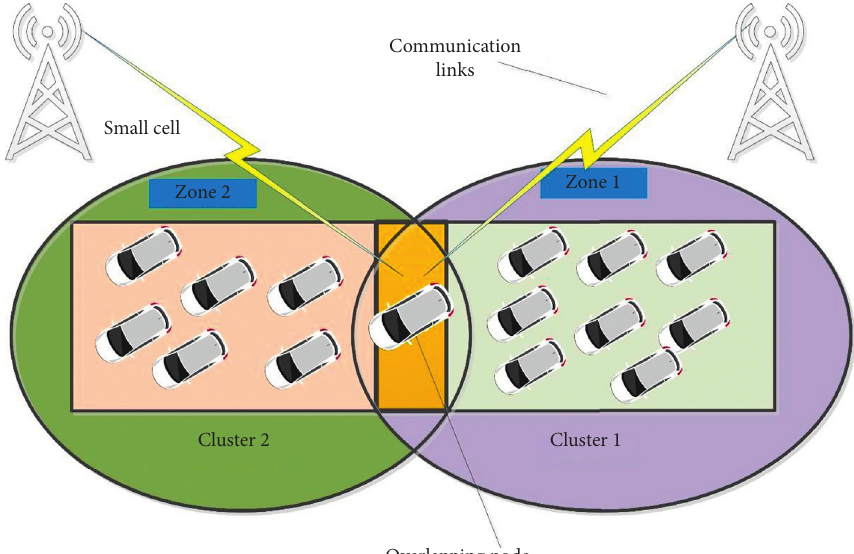
Figure 2: Overlapping vehicles cause interruption between